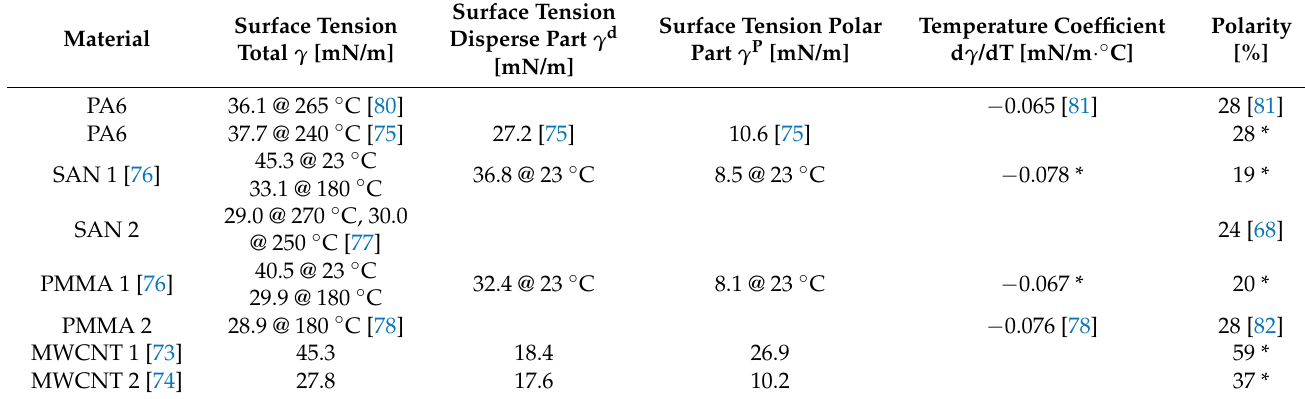
Table A1. Surface tension values of the polymers and CNTs as taken from the literature.